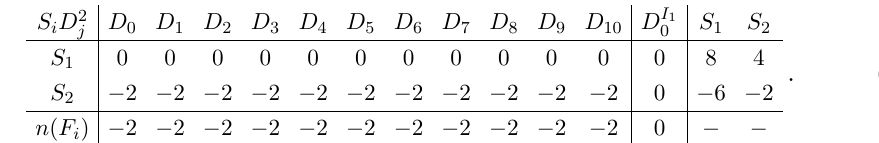
Here we tuned the vanishing order of b